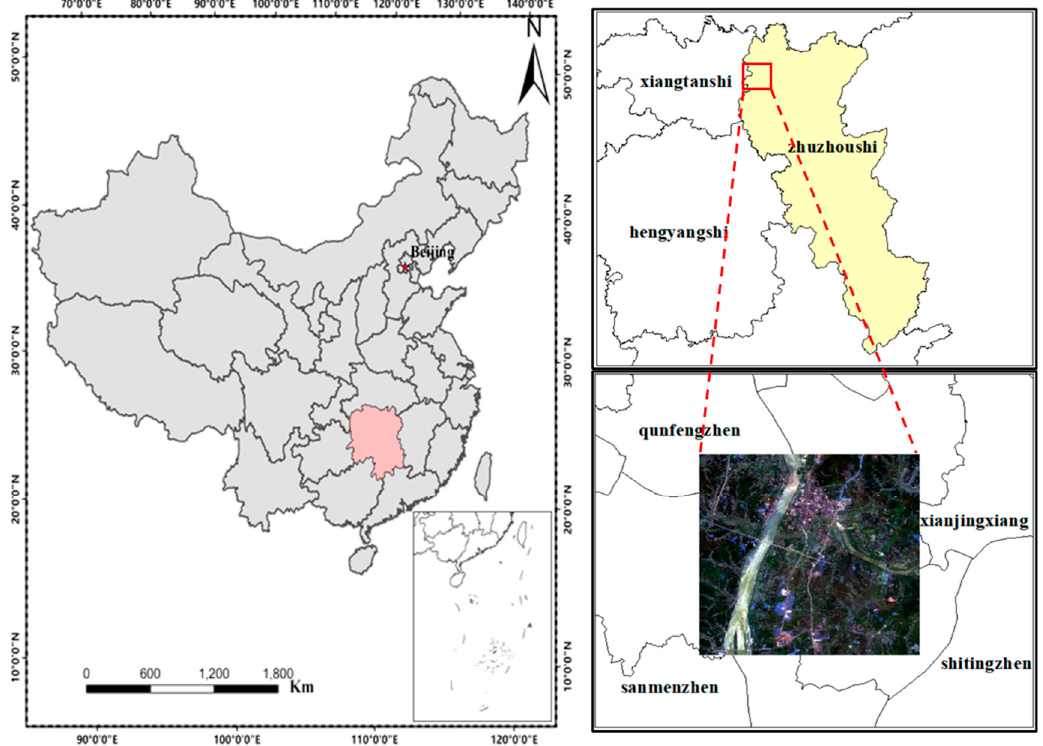
Figure 1. Location map for study areas in Zhuzhou, China.